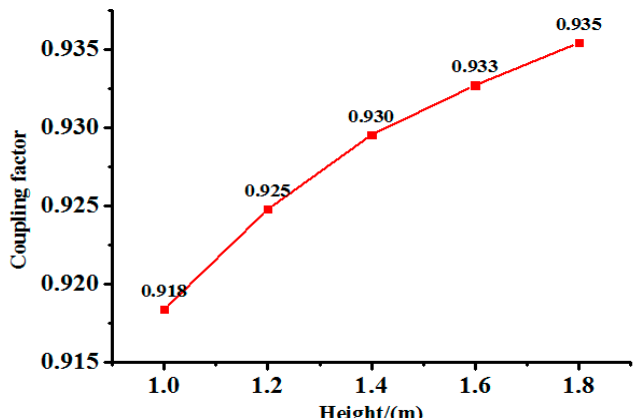
Figure 10. The curve between the encapsulation height and coupling factor (inner radius = 0.36 m).